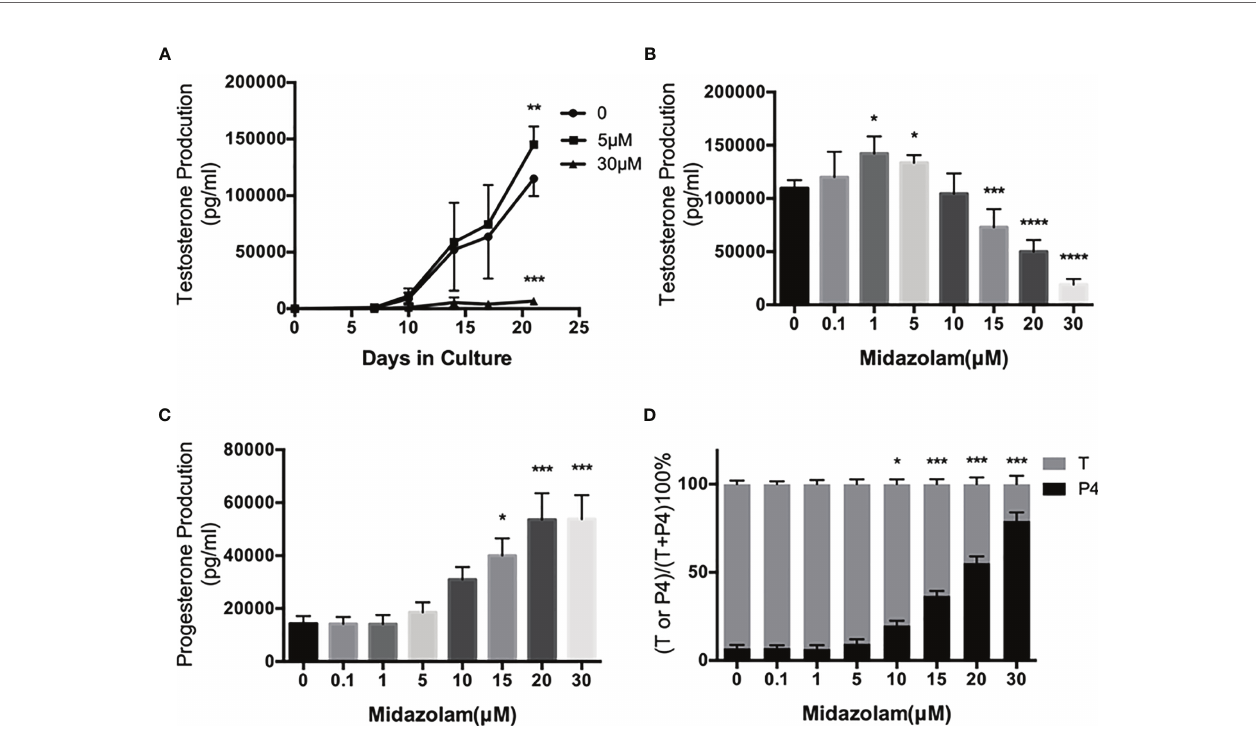
FIGURE 4 | Effects of midazolam on differentiation of stem Leydig cells (SLCS): (A) SLCs were induced to differentiate into testosterone-producing Leydig cells in 21 days in the presence of 5 or 30 m M of midazolam. Testosterone (T) concentrations were assayed in the culture medium collected every 3 – 4 days. (B) T concentrations in the day 21 culture media. (C) Progesterone (P4) concentrations in the day 21 culture media. (D) Percentages of T and P4 in the day 21 culture media. Data are expressed as mean ± SEM of four to six experiments. The experimental repeats for each fi gure are as follows: (A) (4), (B) (6), (C) (4), and (D) (4) . Signi fi cantly different from the control groups at *p < 0.05, **0.01, ***0.001, or